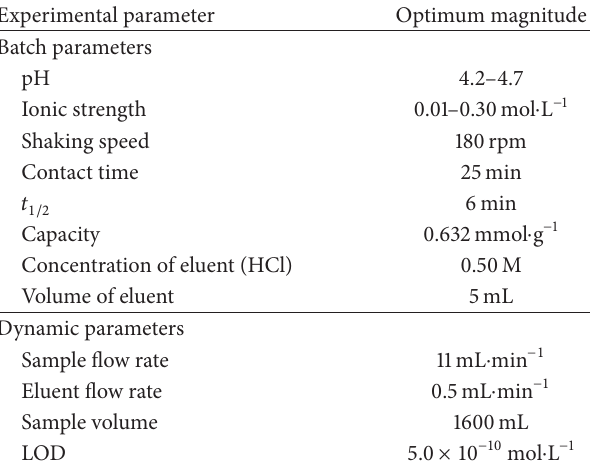
Table 6: Optimized experimental parameters for separation and pre-concentration of U(VI) ions by CAB-impregnated